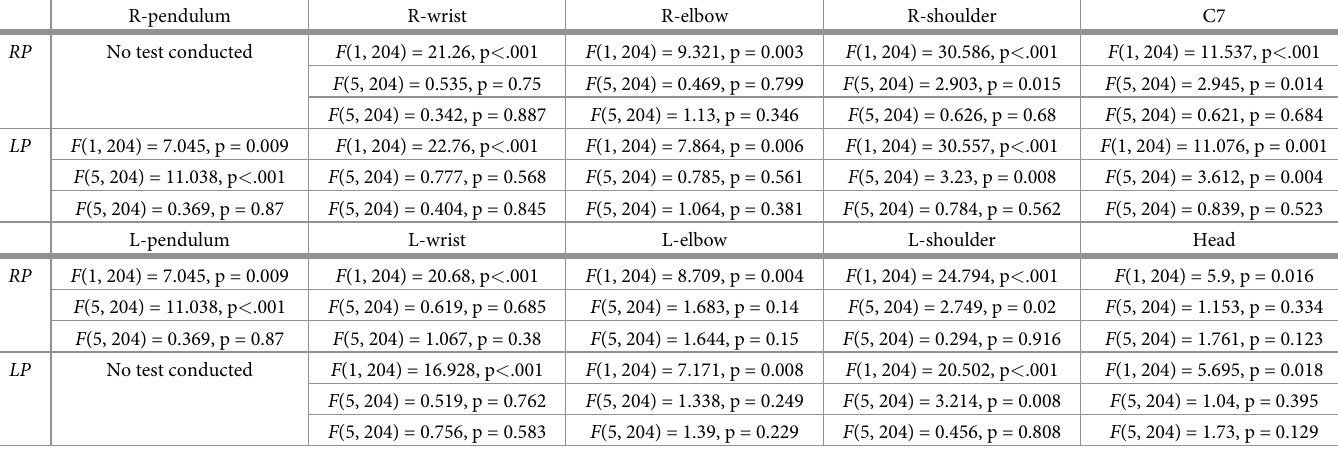
Table 1. Results of two-way ANOVA for first peak value of cross-correlation (in-phase condition). R-pendulum R-wrist R-elbow R-shoulder